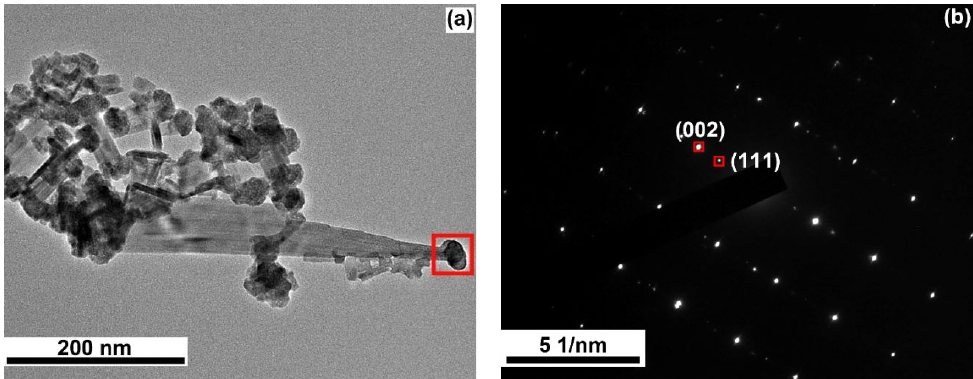
Figure 11. The ( a ) TEM and ( b ) SAED images of samples synthesized hydrothermally at 200 °C for 24 h using 0.18 mmol CsCl, 0.4 mmol WO 3 , 8.8 mmol CH 3 CH 2 CHO, and 2.0 mmol (NH 4 ) 2 C 2 O 4 . The red square is the diffraction region of SAED.